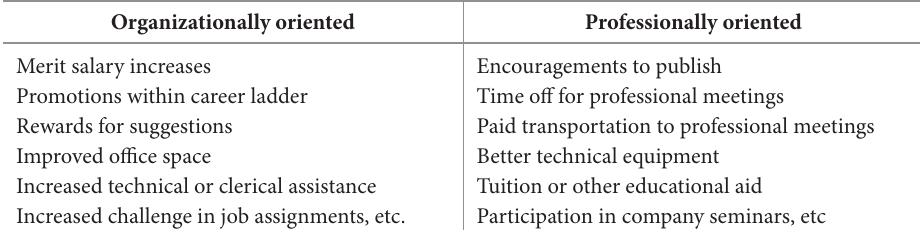
Table 1. Traditional incentives used for motivating workers (According to Badawy 2008) Organizationally oriented